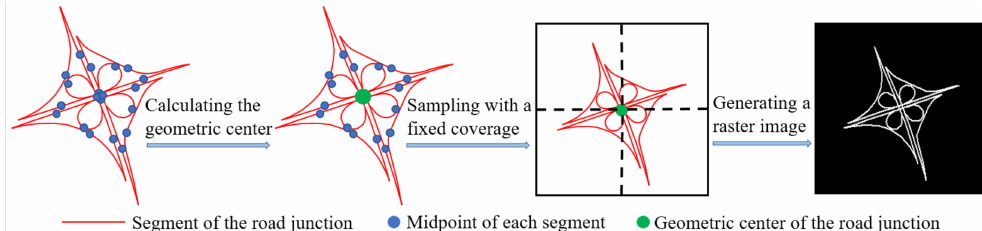
Figure 2. Illustration of the process of generating the raster image for a vector-based complex road junction.